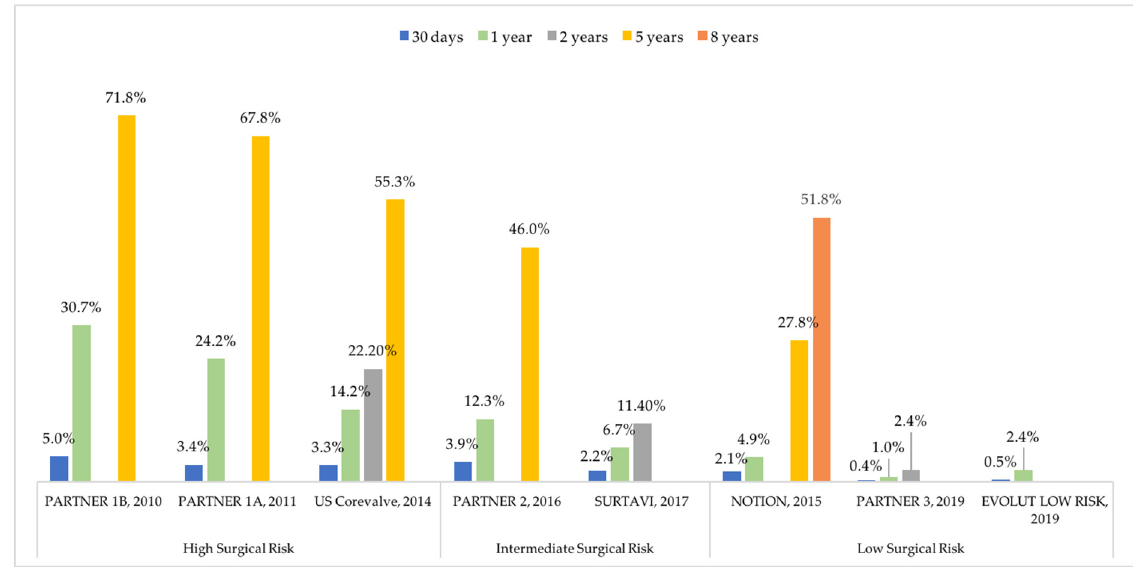
Figure 1. Reported incidences of all-cause mortality after transcatheter aortic valve replacement in pivot trials. NOTION: Nordic Aortic Valve Intervention Trial; PARTNER: Placement of Aortic Transcatheter Valve; SURTAVI: Safety and Efficacy Study of the Medtronic Corevalve© System in the Treatment of Severe, Symptomatic Aortic Stenosis in Intermediate Risk Subjects Who Need Aortic Valve Replacement.